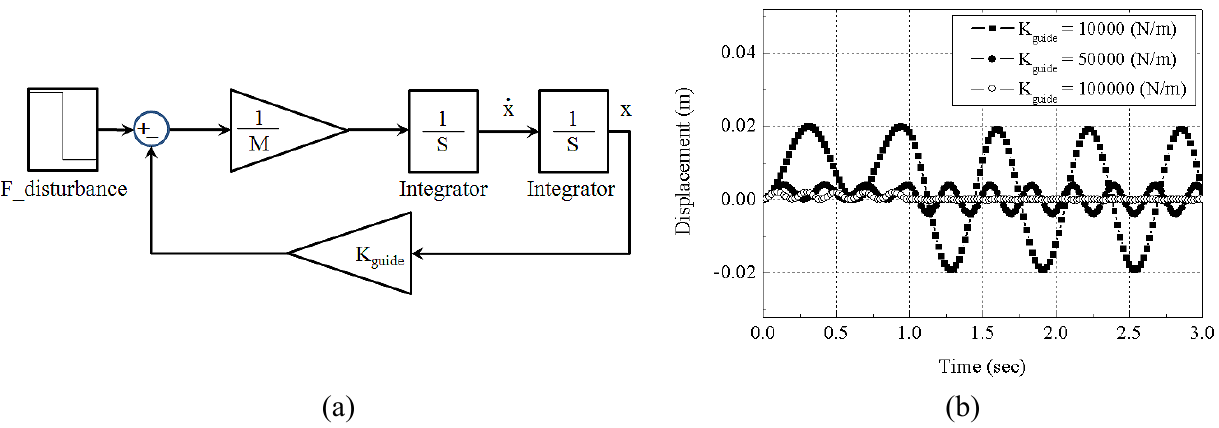
Figure 4 . Lateral position model for electromagnets under constant levitation